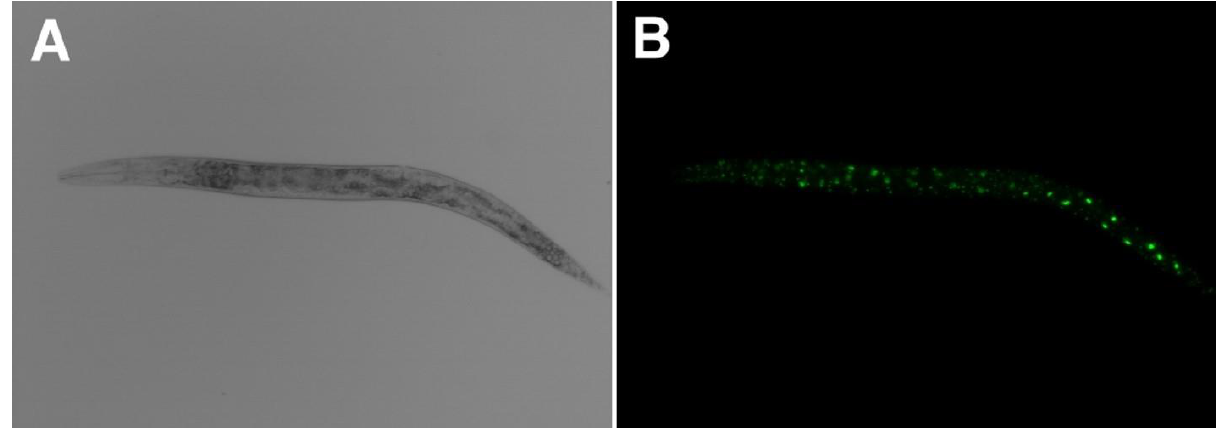
FIGURE 1: Images of C. elegans nematode used as a model to study aging and longevity. (A) Light microscopy and (B) fluorescence micros- copy images of transgenic C. elegans strain CGUIS-1 expressing the nucleolar protein fibrillarin 1 (FIB-1) coupled to green fluorescent protein (GFP). FIB-1 is a marker of nucleolus size that negatively correlates with longevity across taxa [161], making the CGUIS-1 strain useful for screening natural products that may extend lifespan. In B, GFP auto-fluorescence is induced by ultraviolet light. The images are unpublished observations made by the